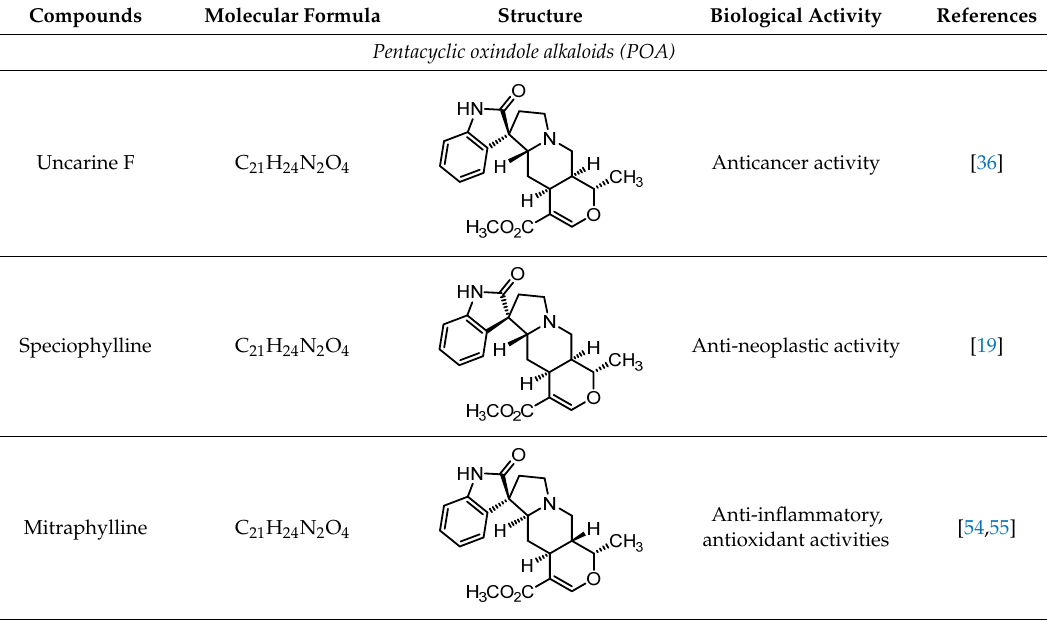
Table 1. List of some of bioactive alkaloids isolated from Uncaria tomentosa.